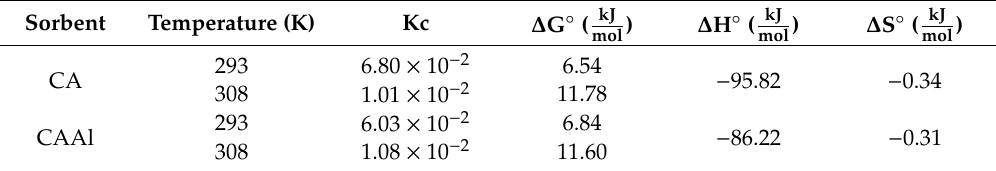
Table 5. Thermodynamic parameters of the